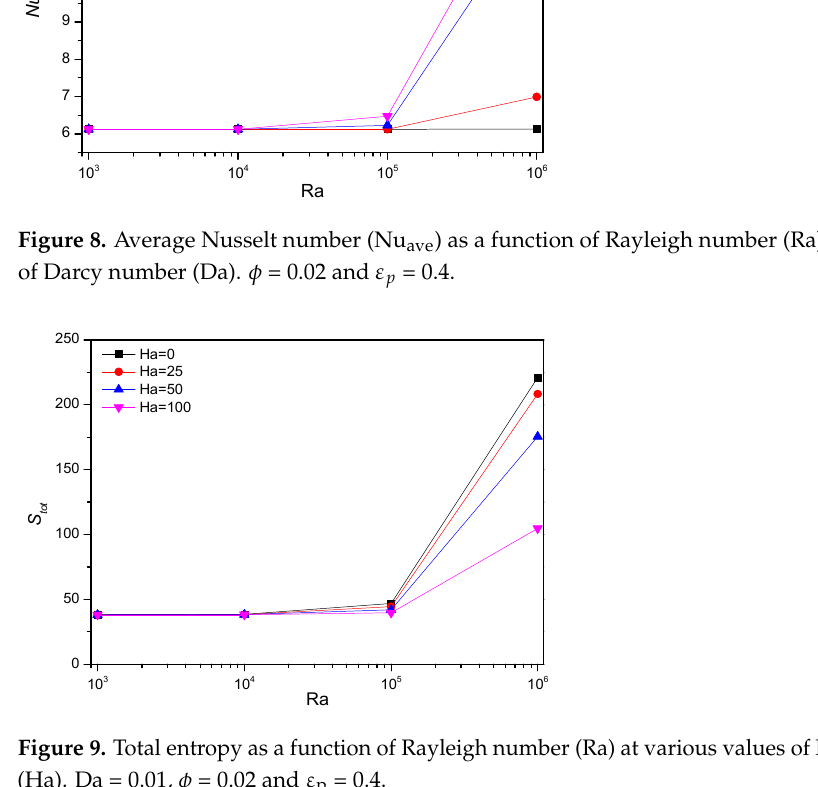
Figure 10. Total entropy as a function of Rayleigh number (Ra) at various values of porosity ( 𝜀 (cid:3043) ) . Η a = 0, Da = 0.01 and 𝜙 = 0.02.